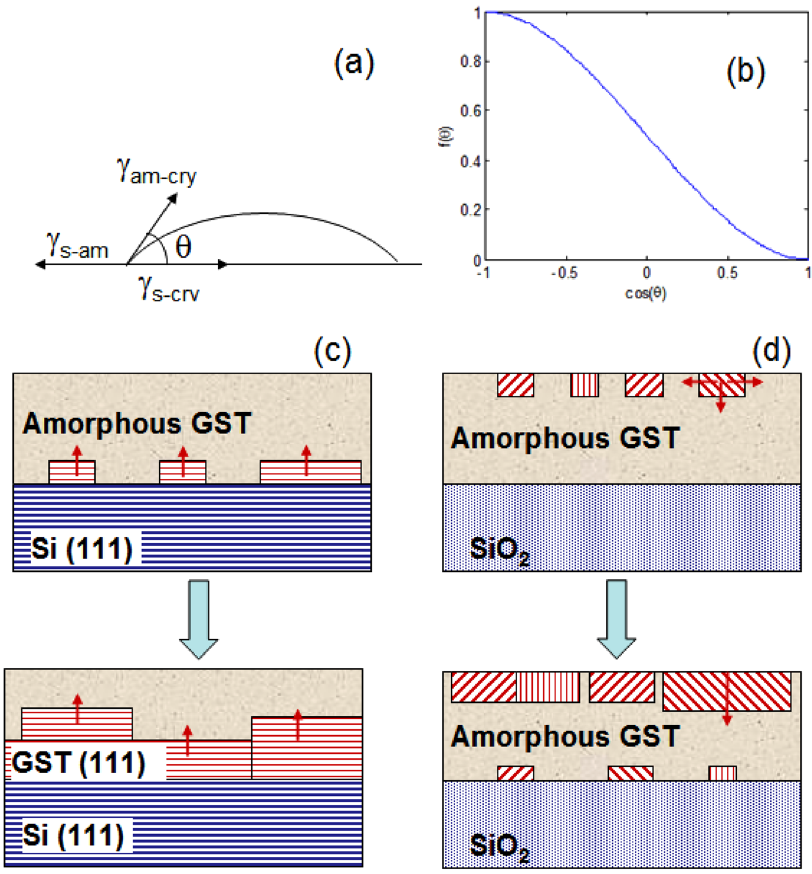
Figure 5. ( a ) Schematic of the surface energy and the contact angle; ( b ) f( θ ) versus cos( θ ). ( c ) and ( d ) Schematic of the heterogeneous nucleation sites and their evolution in the case of Si(111) and SiO 2 substrates,